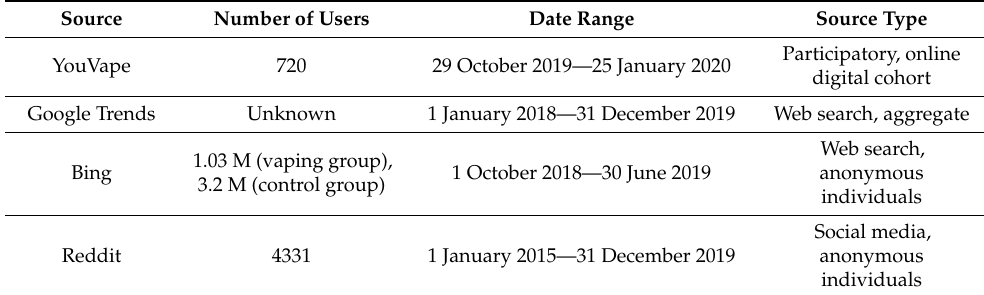
Table 1. Summary of data